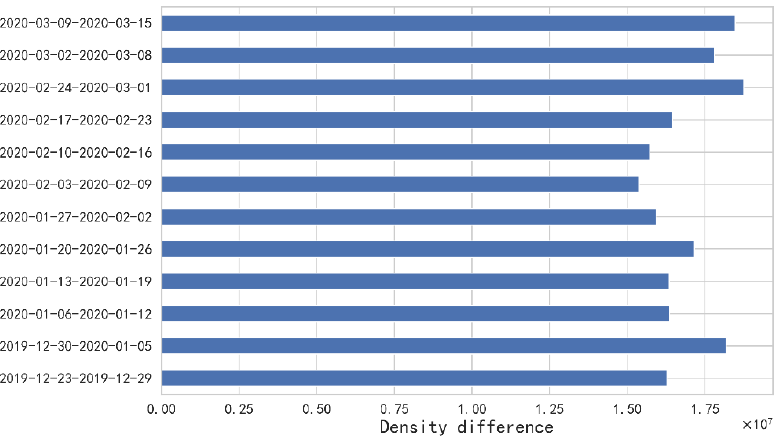
Figure 13. Density differences of the 12 weeks’ datasets.